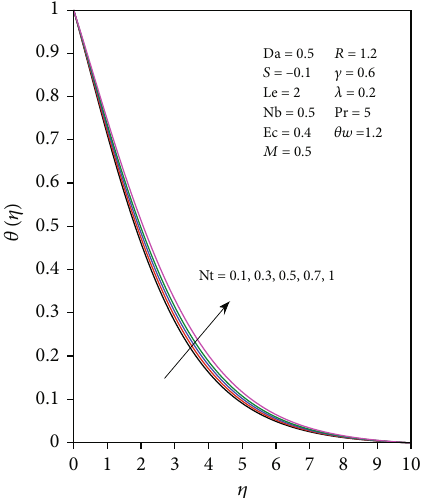
Figure 8: Temperature pro fi le for di ff erent values of Nt .